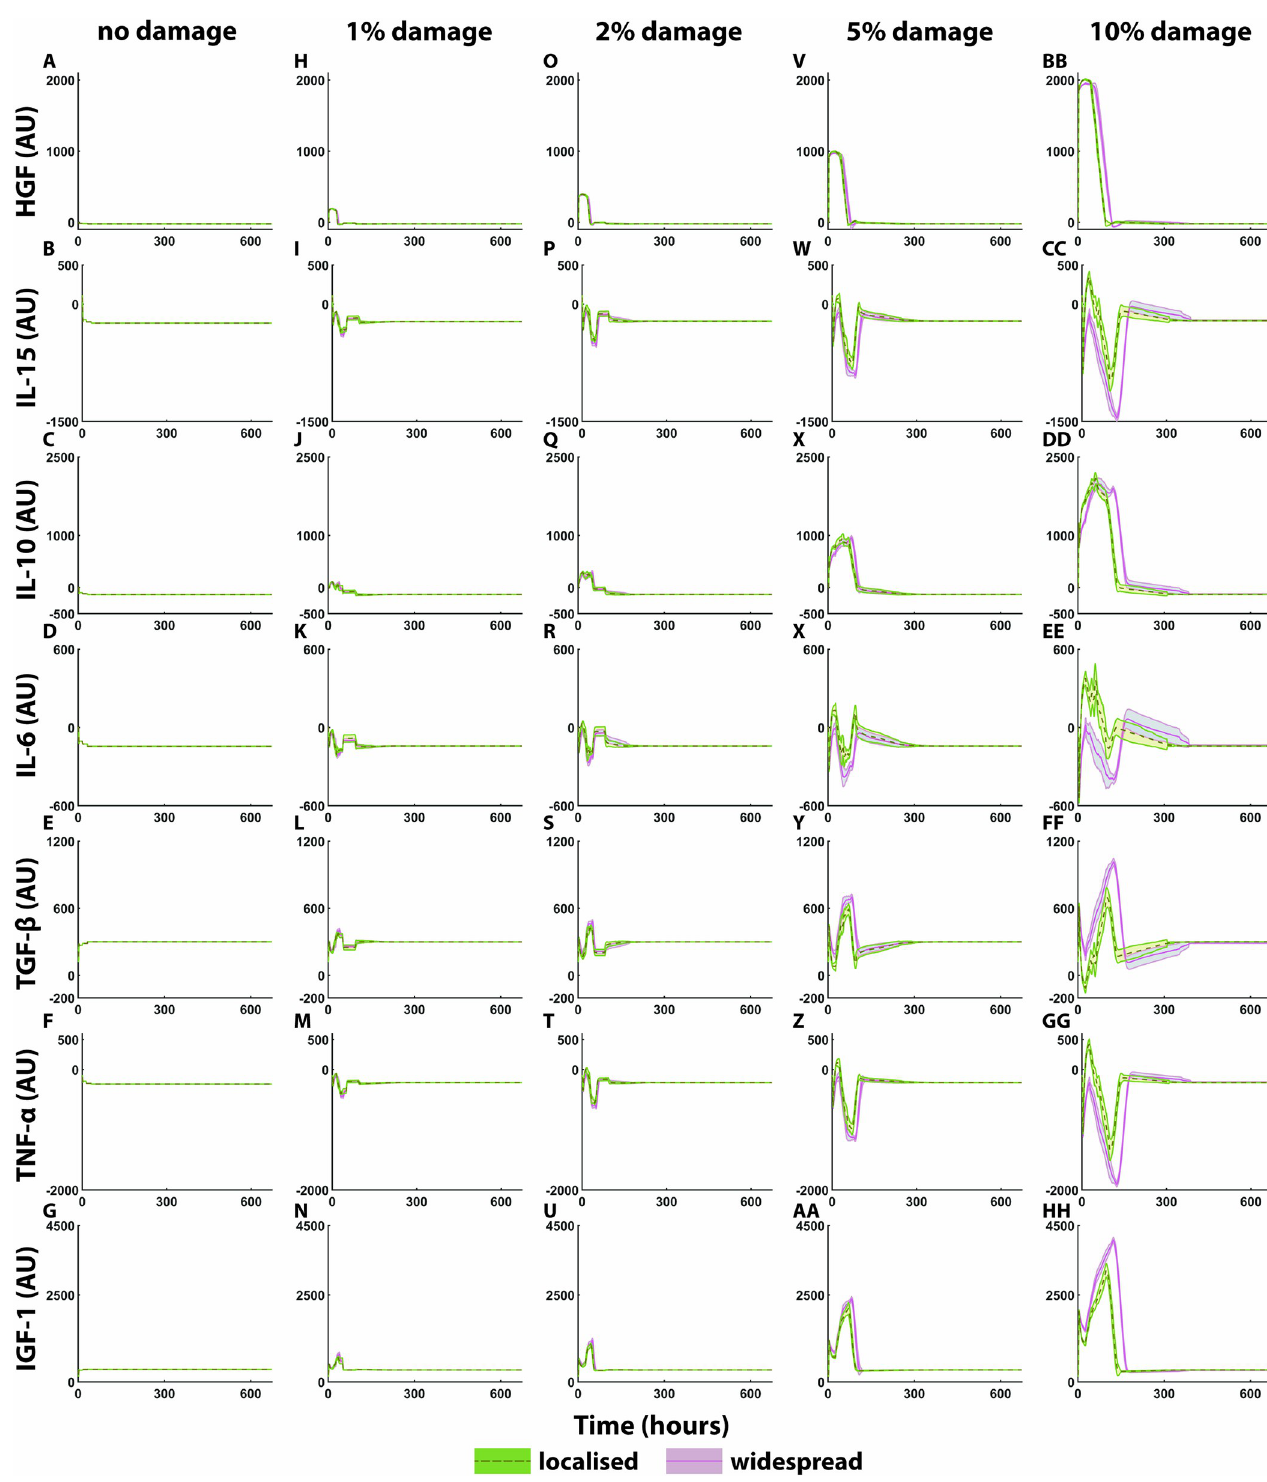
Fig 6. Cytokine and growth factor levels for muscle regeneration over 672 h. (A-G) no damage levels, (H-N) cytokine response following 1% damage, (O-U) 2% damage cytokine response, (V-BB) 5% damage cytokine response, and (CC-II) 10% damage cytokine levels over 672 hours, mean ± SD. In these simulations, 0 represents a starting value or steady state that has been optimised for but is not absolute. The subsequent changes to these values then represent increases or decreases relative to the optimised value.